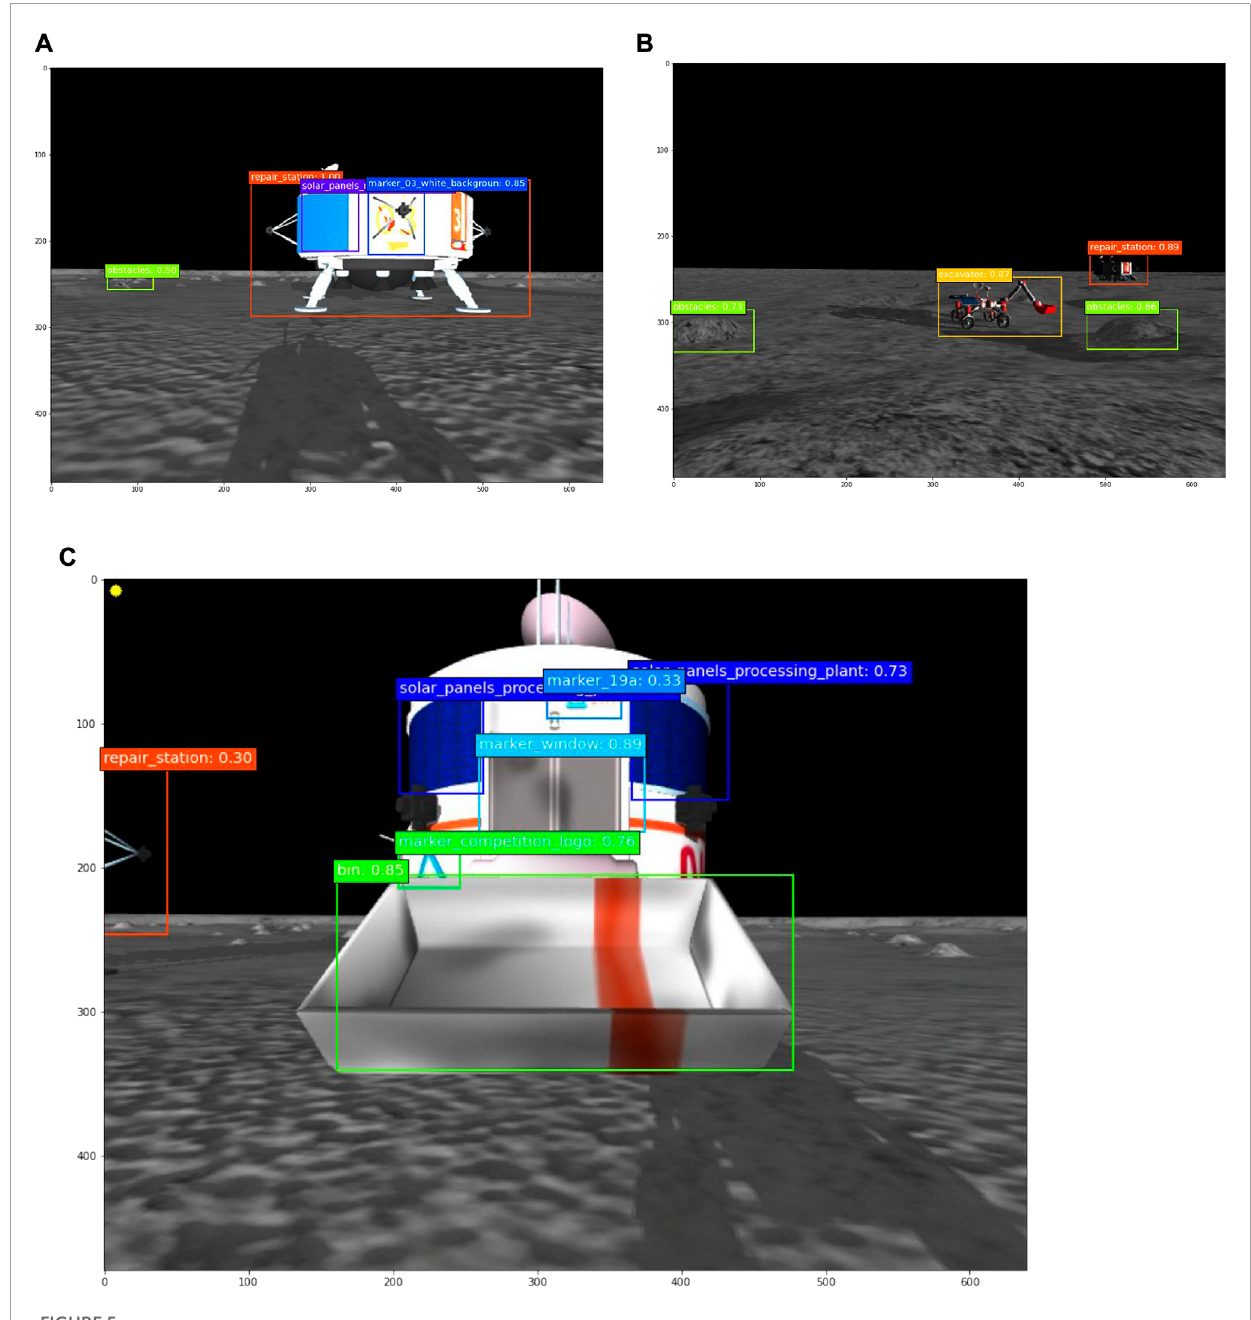
FIGURE 5 Object detected during approach sequence. (A) Charging station. (B) Excavator and obstacles. (C) Processing plant and its bin.